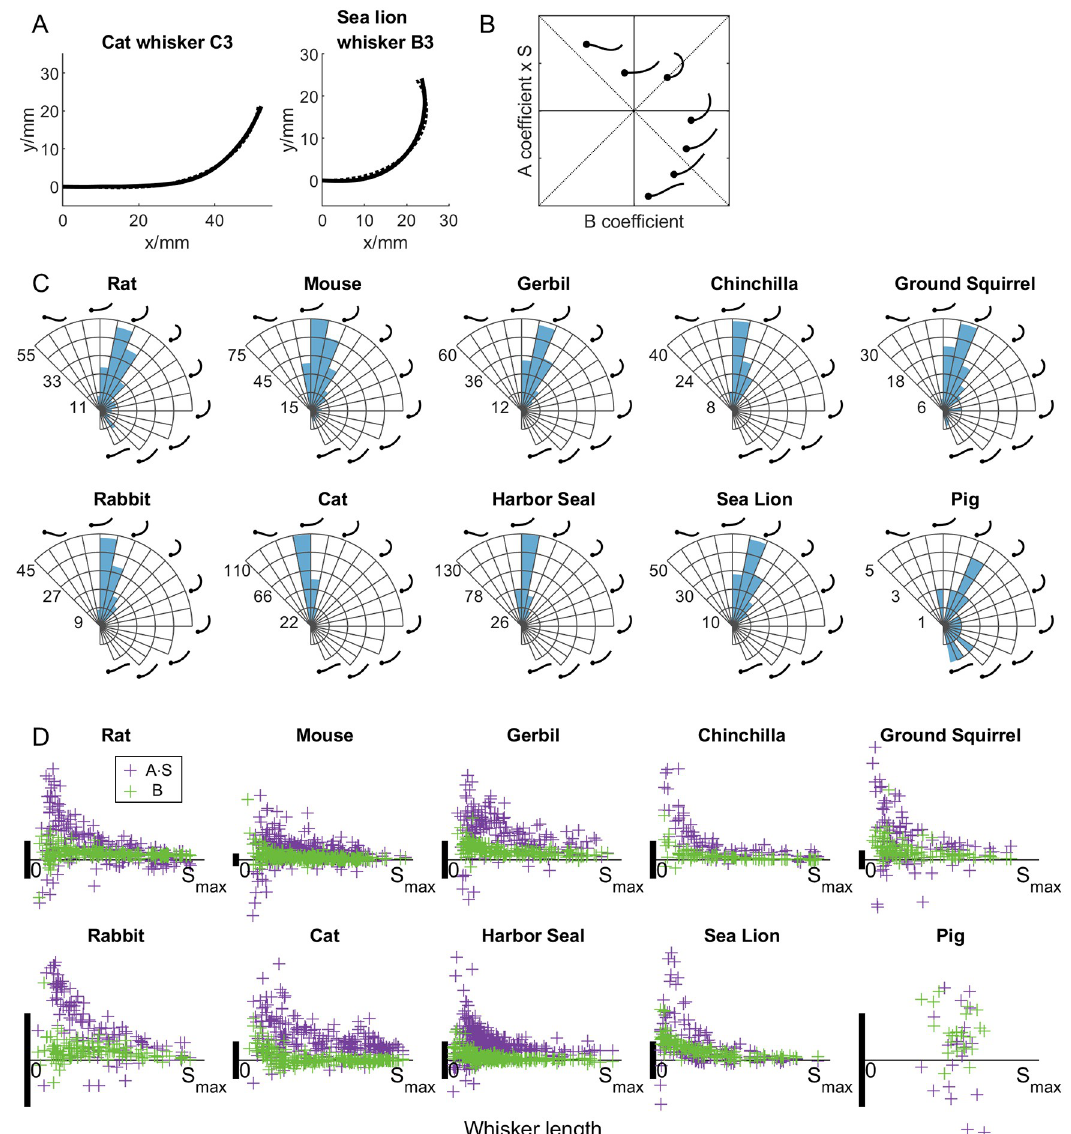
Fig 6. Whiskers can be fit to Ces à ro curves. (A) Two exemplar whiskers fit to Ces à ro equations are shown for cat and sea lion. Solid curve: Whisker. Dotted curve: Fit curve. (B) In the present dataset, whiskers could be classified into 9 different shapes, 7 of which are illustrated in the (B, A � S) coefficient space (two are omitted in the first quadrant for visual clarity). The dots indicate the base of the schematized whiskers. (C) Polar histograms indicate the total number of whiskers in each region of the coefficient space for each species. The coordinates in each panel are the same as in (B). The radial axis indicates the number of whiskers. (D) The two coefficients B and A � S show large variance for short whiskers compared to long whiskers. In all plots the vertical scale bar (heavy black vertical line) represents